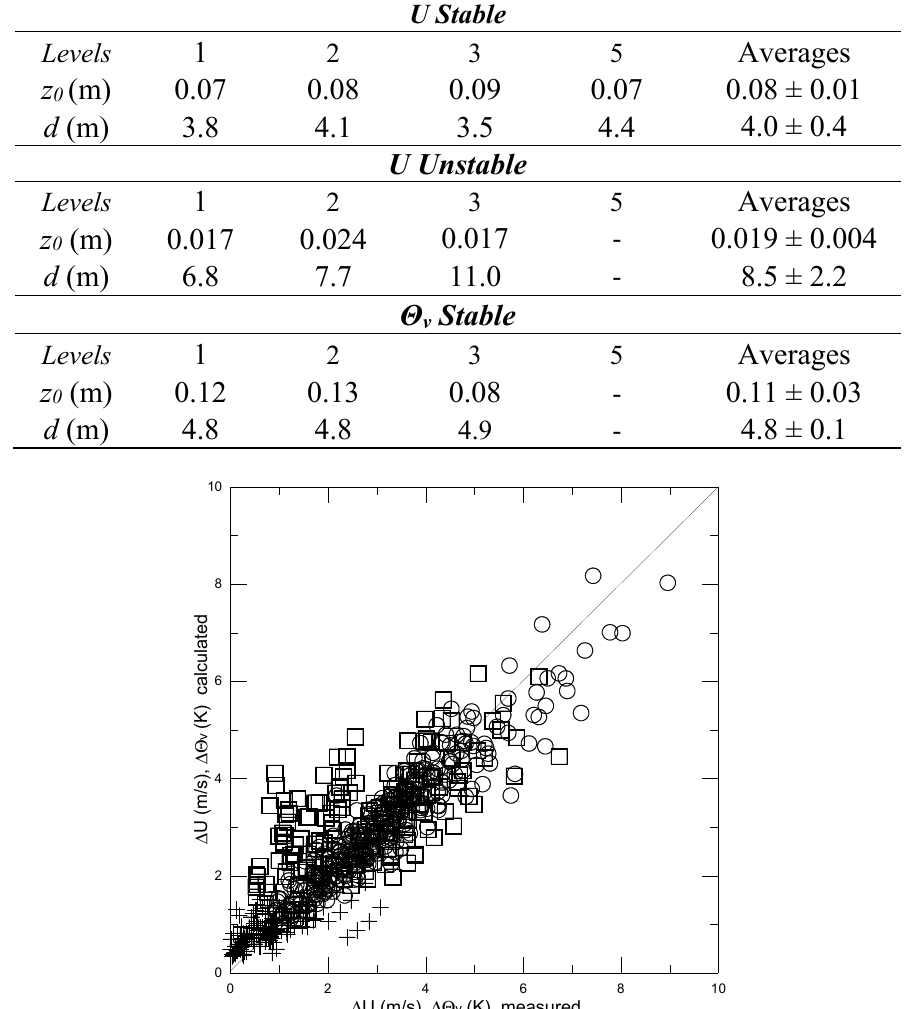
Figure 4. Test for Δ U (stable: circles, unstable: squares) and ΔΘ v (+) calculated between the surface and all measurement levels by the similarity profiles with the averaged parameters in Table 1, versus the measured